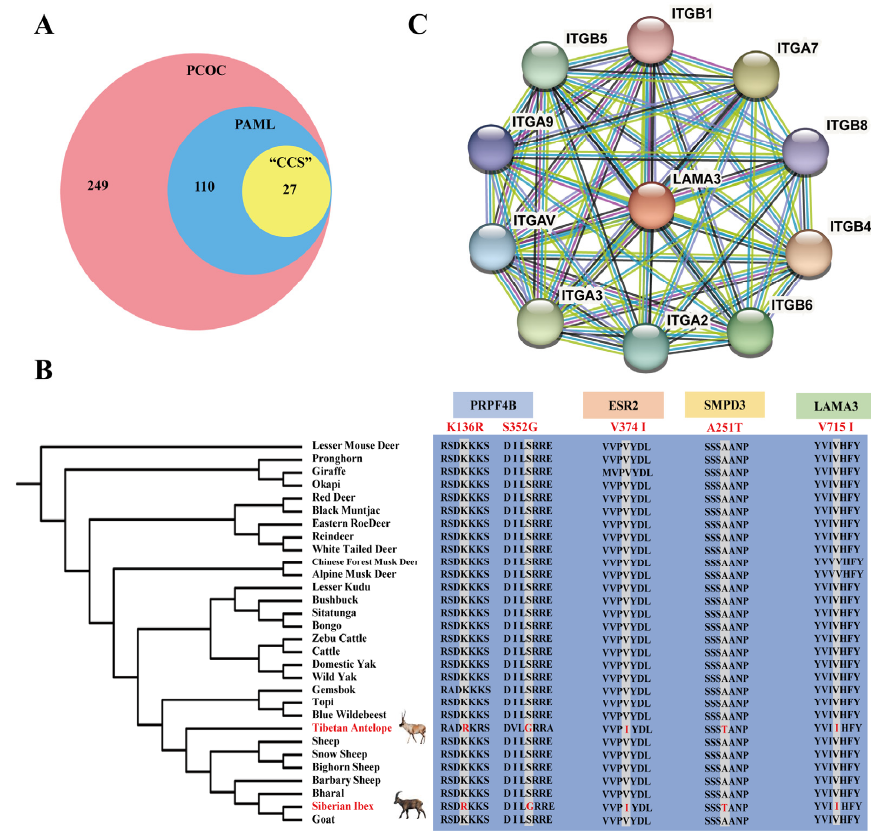
Figure 3. Convergent amino acid substitution genes identified between Tibetan antelope and Siberian ibex. ( A ) Identification of convergent amino acid substitution gene sets using three methods (PCOC: Profile Change with One Change, PAML: Phylogenetic Analysis by Maximum Likelihood, CCS: convergence at conservative sites). ( B ) The convergent amino acid substitution in PRPF4B (Pre- mRNA processing factor 4B), ESR2 (estrogen receptor 2), SMPD3 (Sphingomyelin